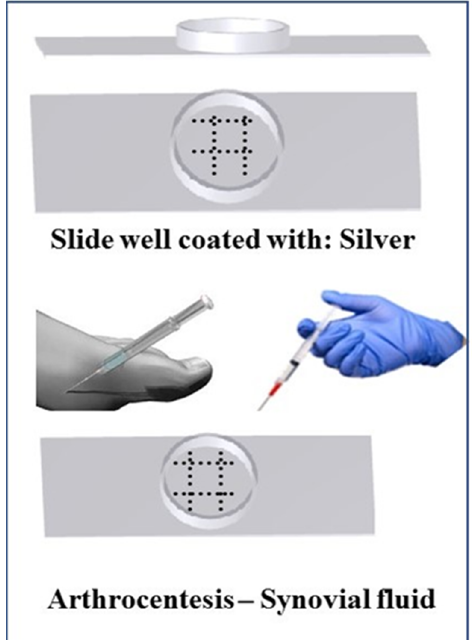
Figure 1. Rapid gout detection device prototype. The device consists of a leak-proof round well of 1.5 mm diameter on a plastic slide. The base of the well will be coated with reactive-ready silver nitrate solution and incubated overnight in a dehydrator to have dried layer of silver nitrate on the